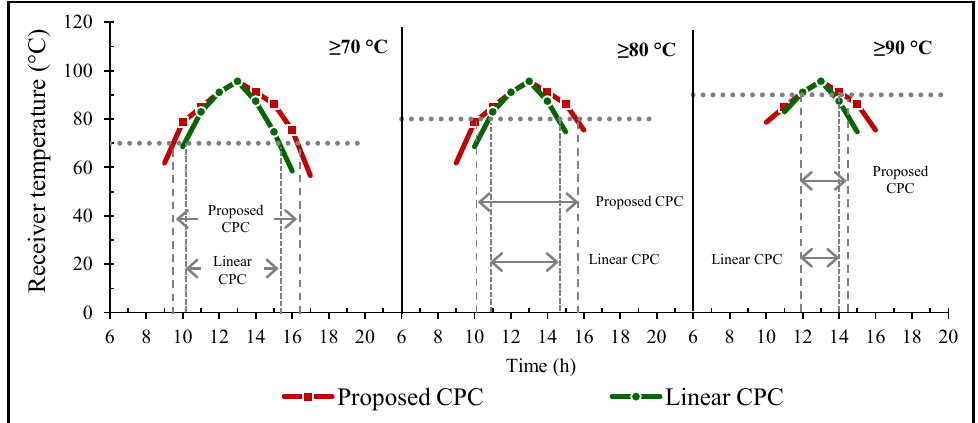
Figure 11. Duration of the selected temperatures per unit length of the proposed angled CPC and linear south-facing CPC (16 February 2005).